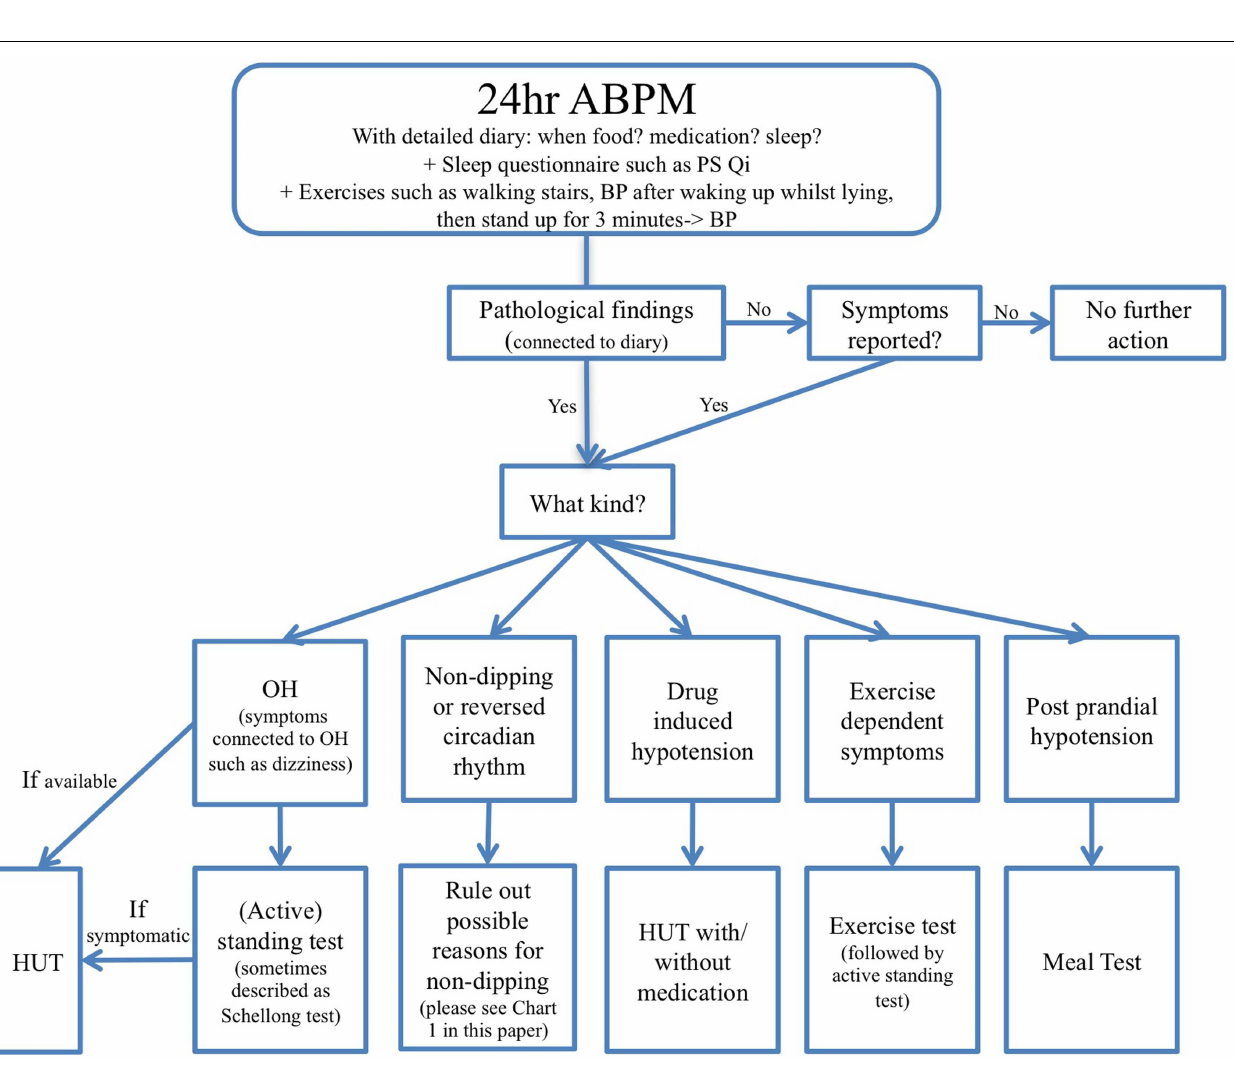
CHART 2 |Twenty-four hourABPM monitoring flow chart for